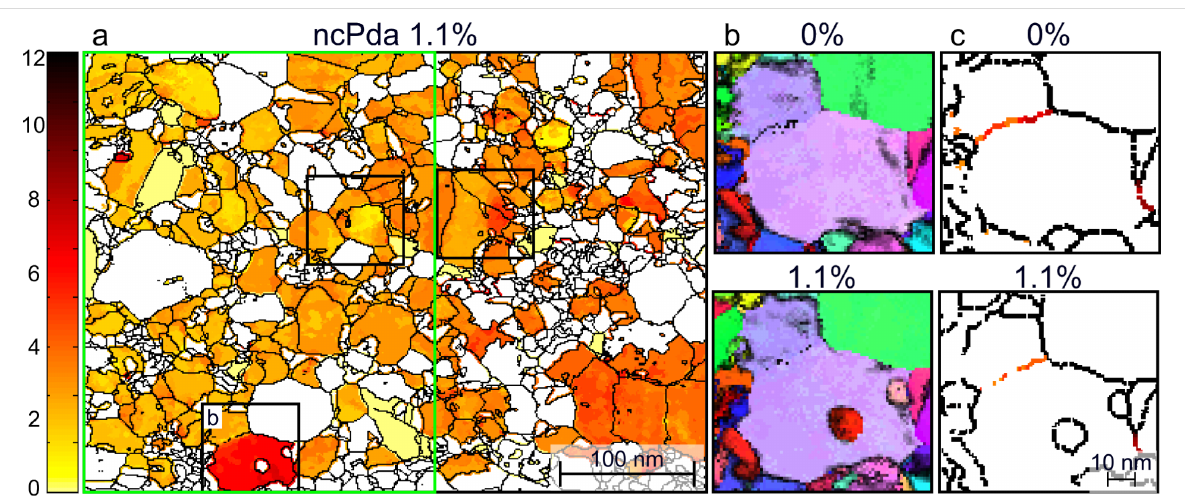
Figure 5: Analysis of the crystallite rotations in the range 0–12° for ncPda: (a) Crystallite boundary map of ncPda overlaid with the rotation of each pixel of individually tracked crystallites for the 1.1% strain state. The color code for the overlaid rotation of the crystallites is displayed on the left. (The green frame is the area which is evaluated in Figure 6 and additional black boxes indicate local deviations from the sample bending) (b) ACOM-STEM orientation maps of a selected area marked in (a). Projection direction: along the tensile direction; color code is given in Figure 1c. (c) Boundary disorientation plot of (b) with color coding according to